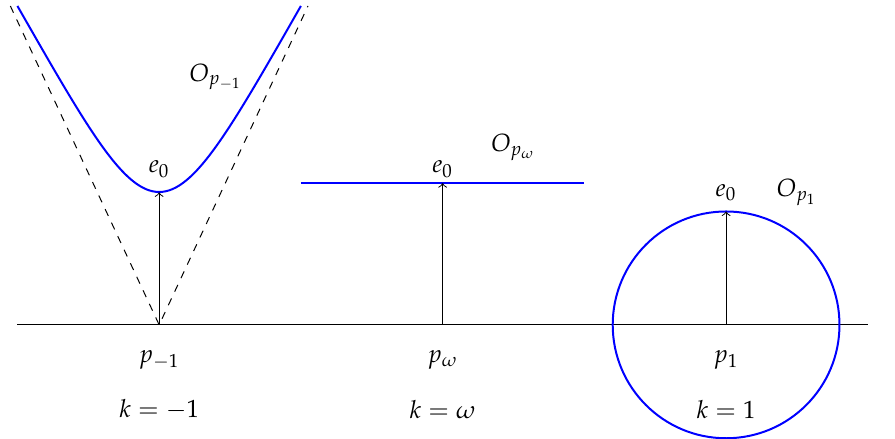
Figure 1. Signature changing spacetime on M = R 2 : The natural coordinate basis B = ( e 0 , e 1 ) ≡ ( ∂ t , ∂ x ) is assumed to lie on S at each point. The matrices of the metric g and g ∗ are